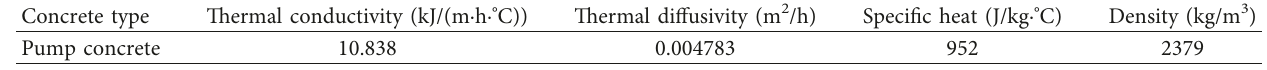
Table 1: Thermal parameters for the sluice pier concrete.